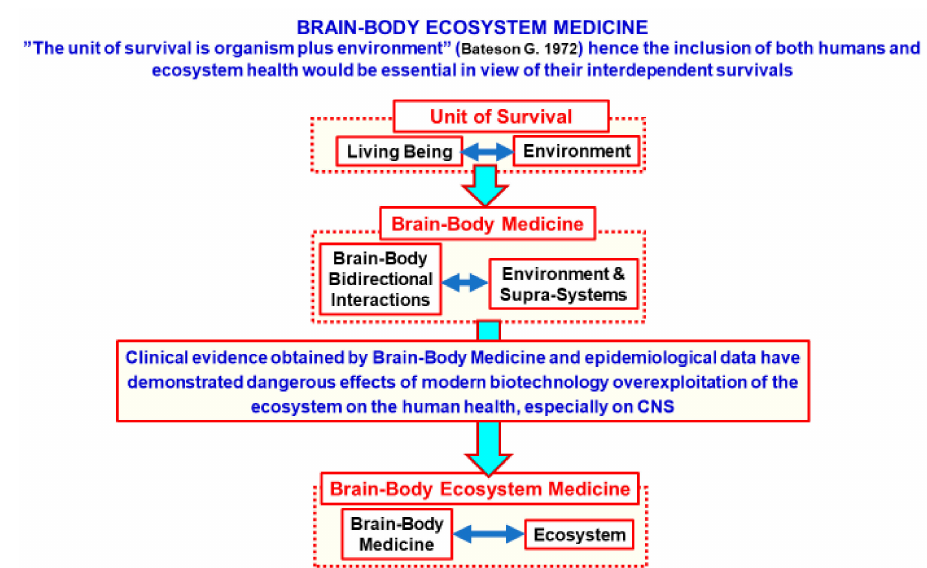
Figure 1. Schematic view of the main steps leading to the brain-body-ecosystem medicine. It